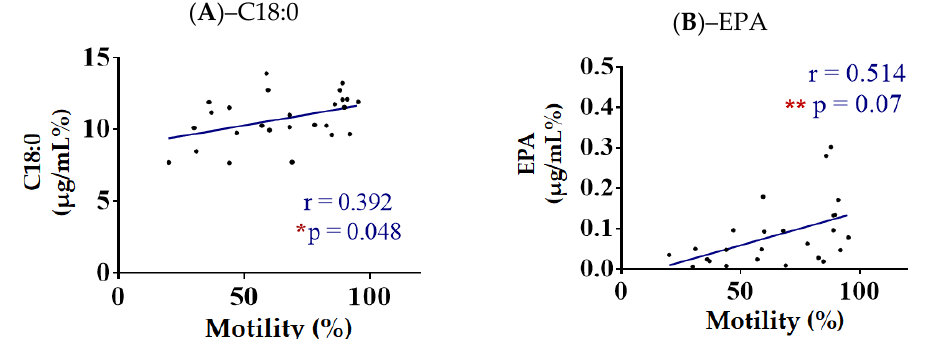
Figure 2. Spearman correlation with linear regression and parameters for 26 healthy donkeys (using motility (%) and lipid indexes obtained from spermatozoa membranes. Values significantly different when compared to with each other: (*) p < 0.05 and (**) p < 0.005. Significant increased levels of stearic-C18:0 ( A ) and EPA ( B ) with the increase in the motility (%) of the spermatozoa.